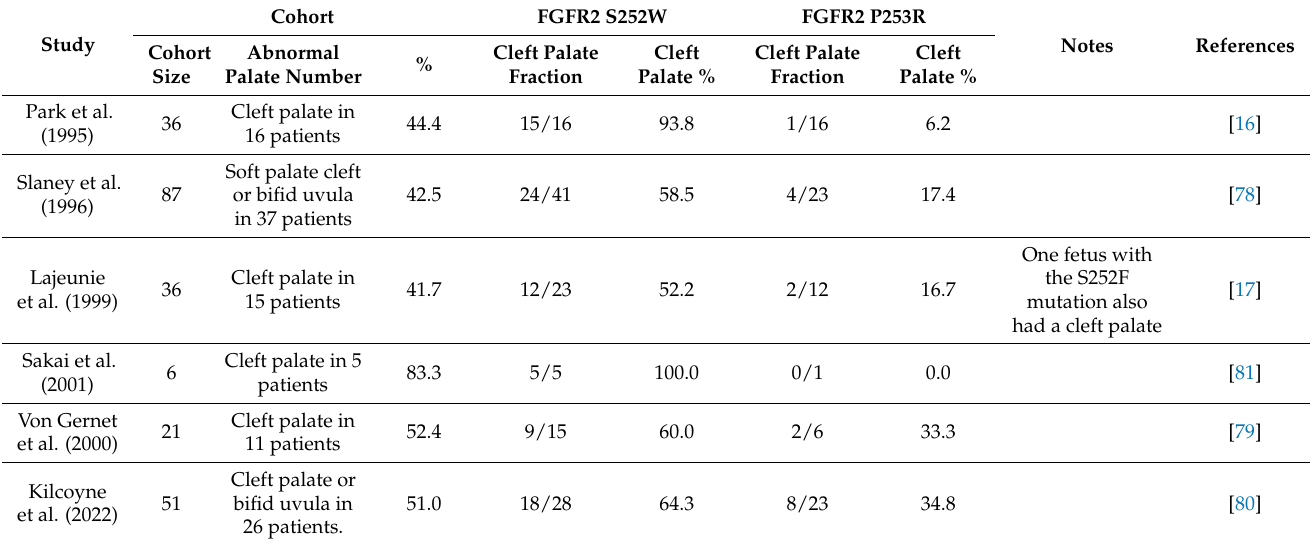
Table 3. Genotype–phenotype correlations of cleft palate with the FGFR2 S252W and P253R